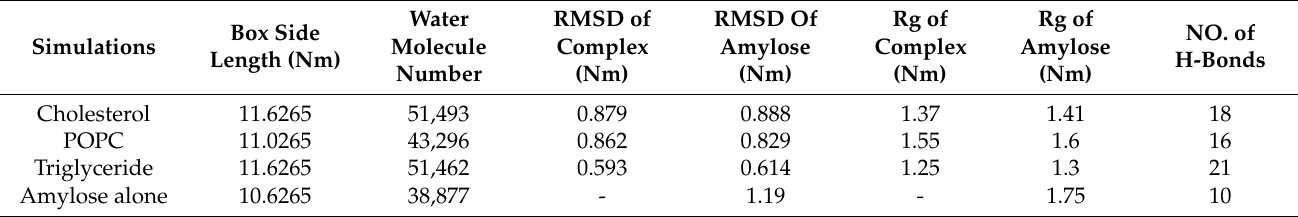
Table 1. Cubic box side length, water number and time average (800–900 ns) conformation parameters of amylose-lipid complexes and one amylose